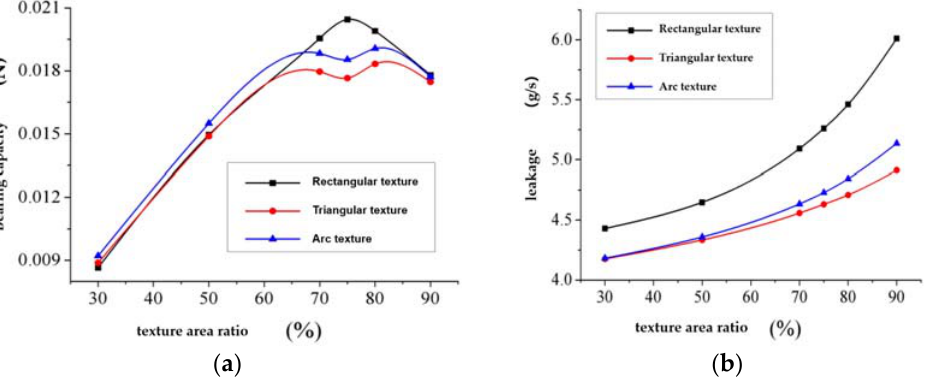
Figure 11. Effect of texture area ratio on sealing performance. ( a ) Effect of texture area ratio on bear ‐ ing capacity; ( b ) Effect of texture area ratio on leakage. bearing capacity; ( b ) Effect of texture area ratio on